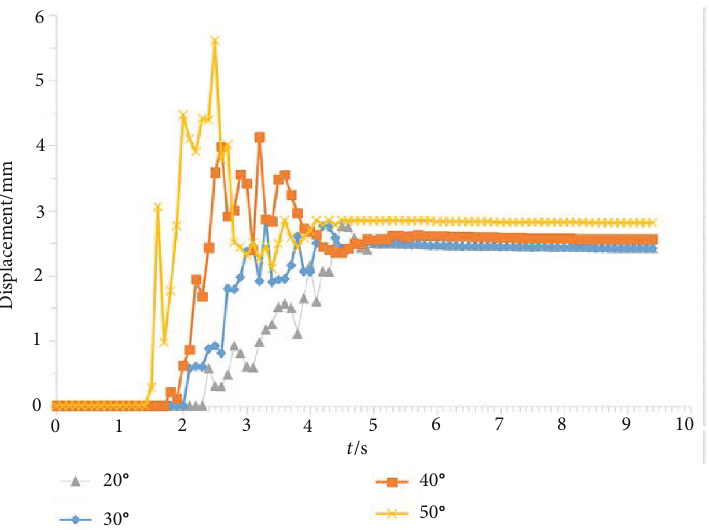
Figure 7: Time-history analysis of displacement of monitoring points of the retaining